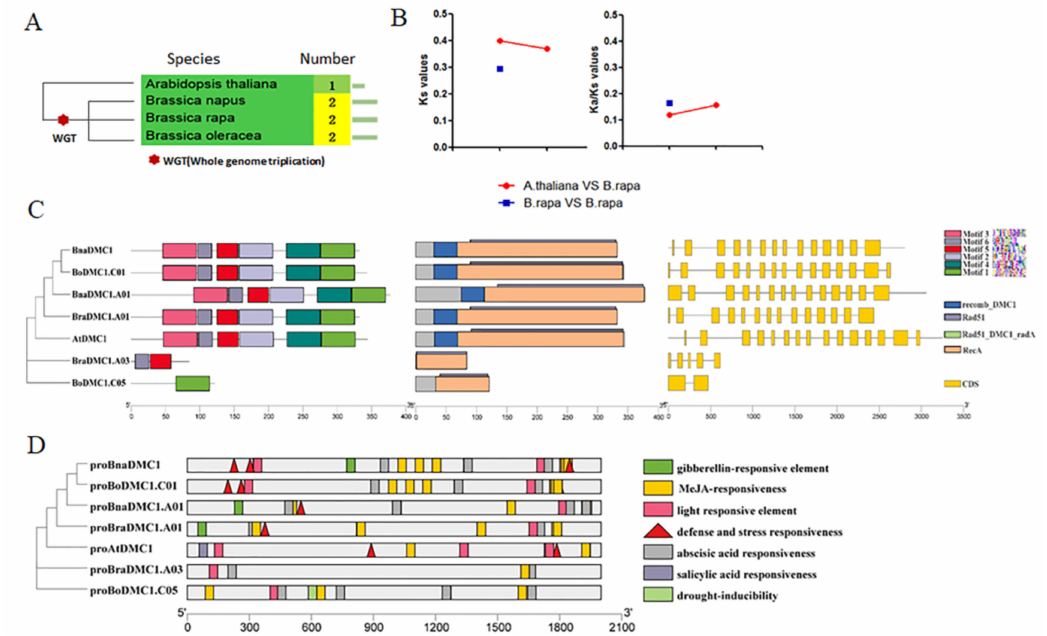
Figure 1. DMC1 genes following WGT in Brassica species. ( A ) The number of DMC1 gene copies that Arabidopsis thaliana (A. thaliana) and Brassica species have retained. Phylogenetic tree of DMC1 was constructed in whole protein sequences. ( B ) The Ka/Ks between BrDMC1 and AtDMC1 . ( C ) DMC1 gene structures and conserved motifs. An unrooted phylogenetic tree was derived from the full-length amino acid alignment of all DMC1 proteins. MEGA7 was used to build the tree, and maximum likelihood (ML) and bootstrap values were calculated with 1000 replications. ( D ) DMC1 promoter cis -acting element